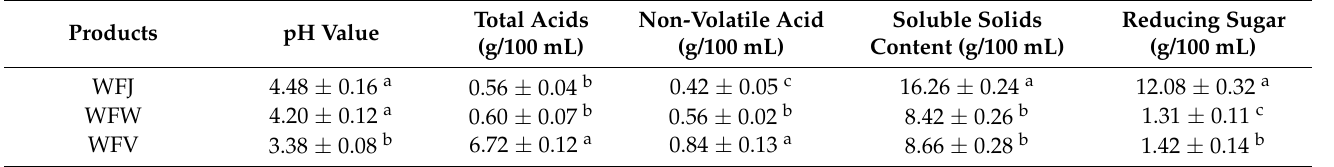
Table 1. Contents of the physicochemical parameters in the fermentation processes of wolfberry fruit